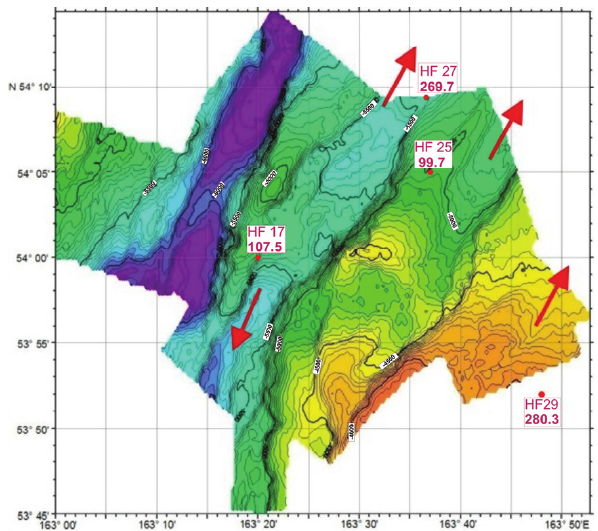
Fig. 5. Area 13: shown is the bathymetry, major erosion channels (red arrows) cut into the western flank of Meiji Seamount, which presently descends toward the subduction trench (violet color) off- shore Kamchatka. Positions of heat flow stations and heat flow val- ues in mWm − 2 , measured during cruise SO201-2, are indicated in red. Bathymetry is based on data collected during SO201-2 by R/V Sonne . The high heat flow values in old oceanic crust are be- lieved to be caused by deep seated natural convection in a tectoni- cally stressed and newly fractured medium. Map was provided by B. Baranov (personal communication,